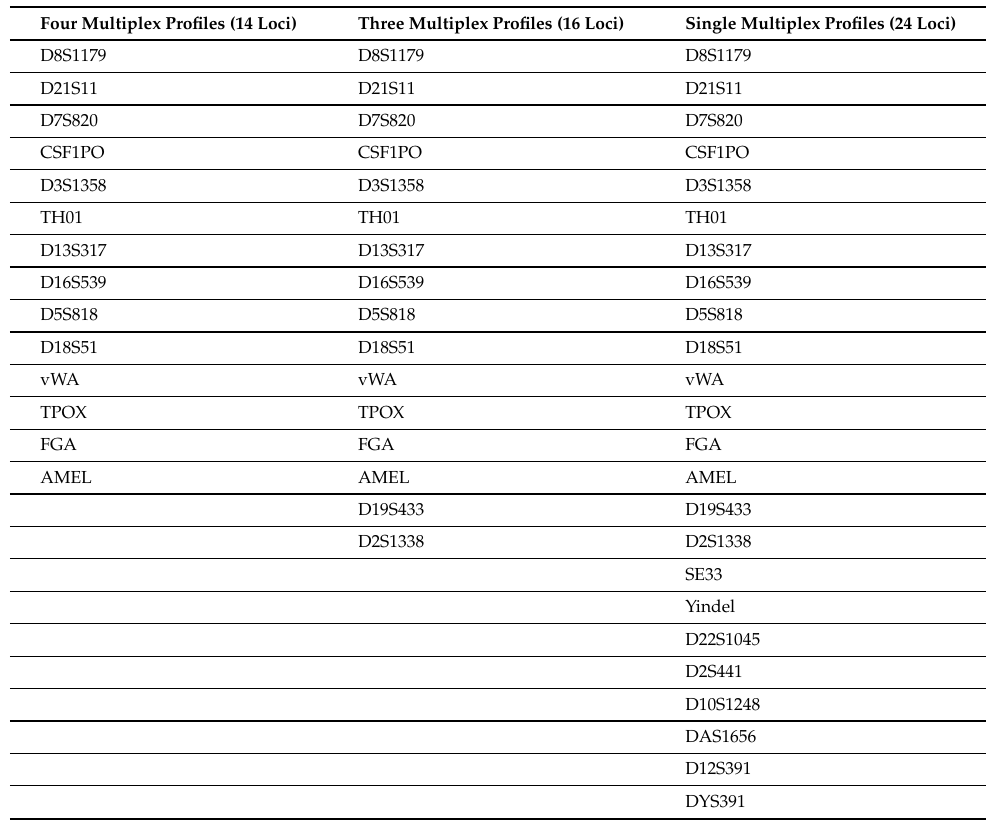
Table 4. Profile loci for the three